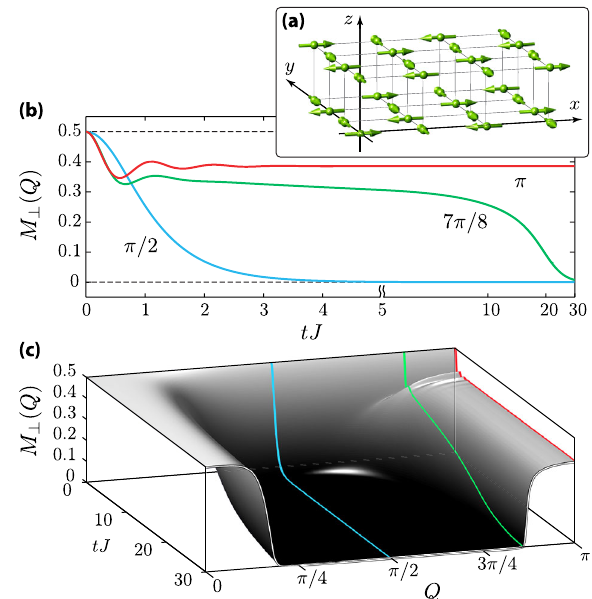
FIG. 1. Relaxation of spin spiral states in the 3D isotropic Heisenberg model. (a) The system is prepared in a spin spiral state in the xy plane with the winding Q ¼ ð Q; Q; Q Þ as tuning parameter. The figure illustrates the case Q ¼ π = 2 . (b) The real- time evolution of the transverse magnetization M ⊥ for three different Q as indicated in the plot. For Q ¼ 7 π = 8 , a hierarchical relaxation process emerges with a nonthermal plateau at inter- mediate times. The time scale is switched to logarithmic at tJ ¼ 5 for better visibility. (c) A global view of the spiral dynamics. Nonthermal plateaus appear near Q ∼ 0 ; π